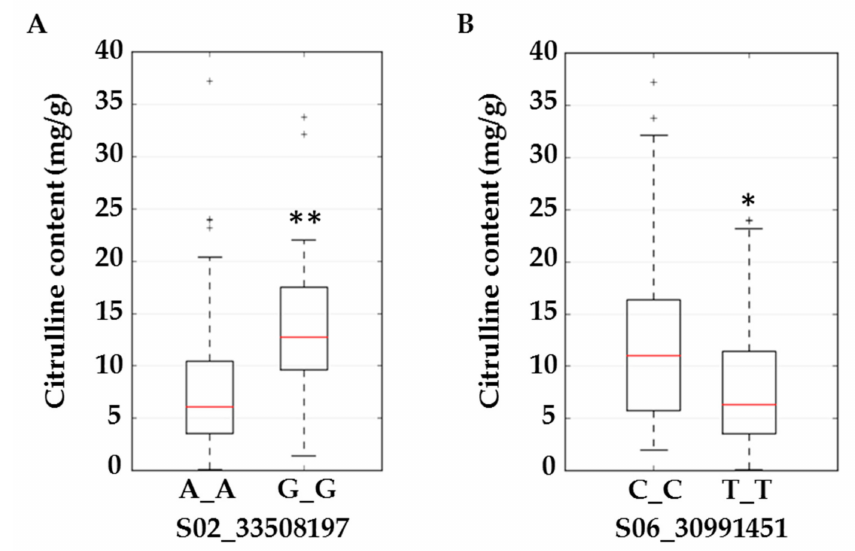
Figure 4. Boxplots for citrulline content (mg / g) in flesh tissue at SNP S02_33508197 located in the intron of ferrochelatase ( A ) and S06_30991451 located in an exon of acetolactate synthase ( B ). Significant di ff erences (based on the Kruskal–Wallis test) with p ≤ 0.01 and p ≤ 0.05 are marked with two (**) and one (*) asterisks